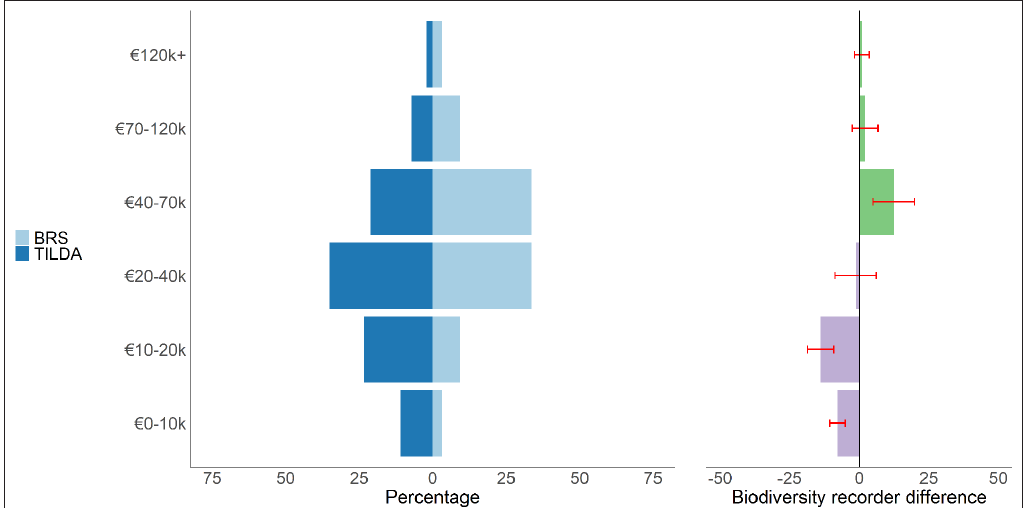
Figure 3: Household income distribution comparison of biodiversity recorders with older adult population in Ireland using The Irish Longitudinal Study on Ageing (TILDA). Note that 95% confidence intervals are based on difference in proportions